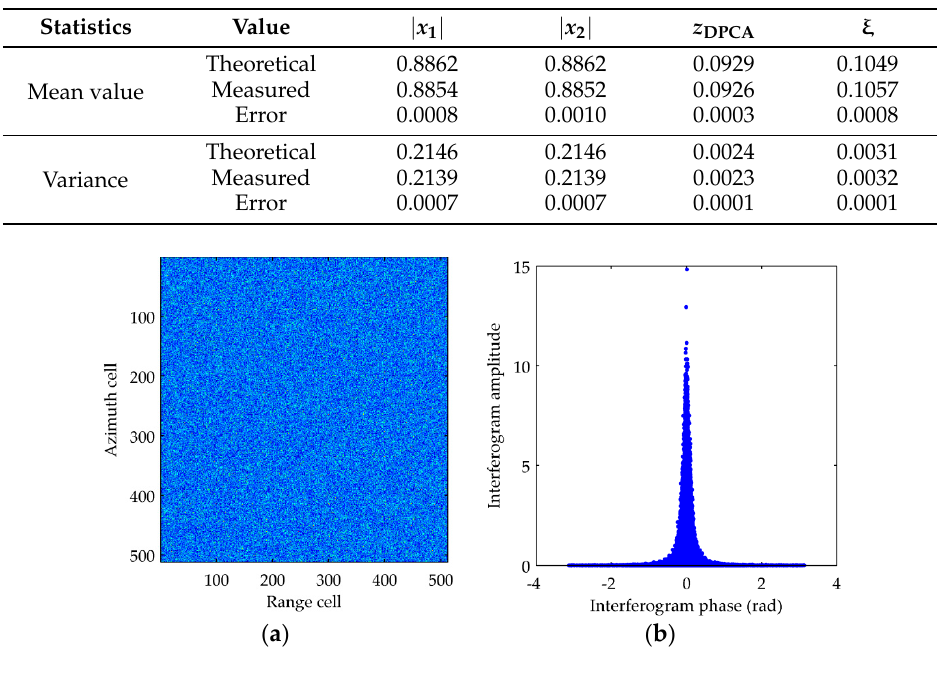
Table 1. Theoretical and measured mean value and